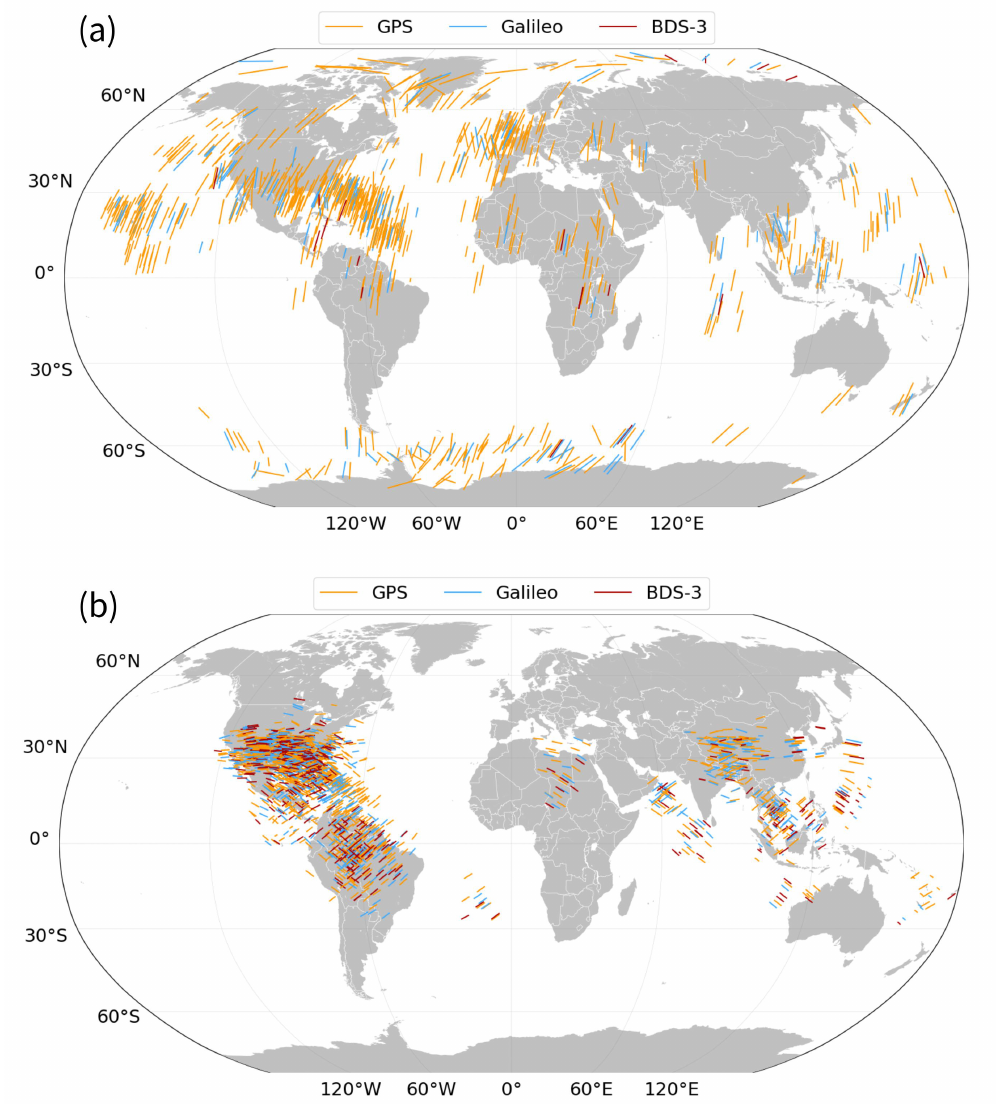
Figure 3. Geographical distribution of the complex waveform product tracks processed from the raw IF data collected by ( a ) the UK TechDemoSat-1 satellite and ( b ) the CYGNSS constellation. The color of each track indicates the source of the GNSS transmitter (GPS, Galileo or